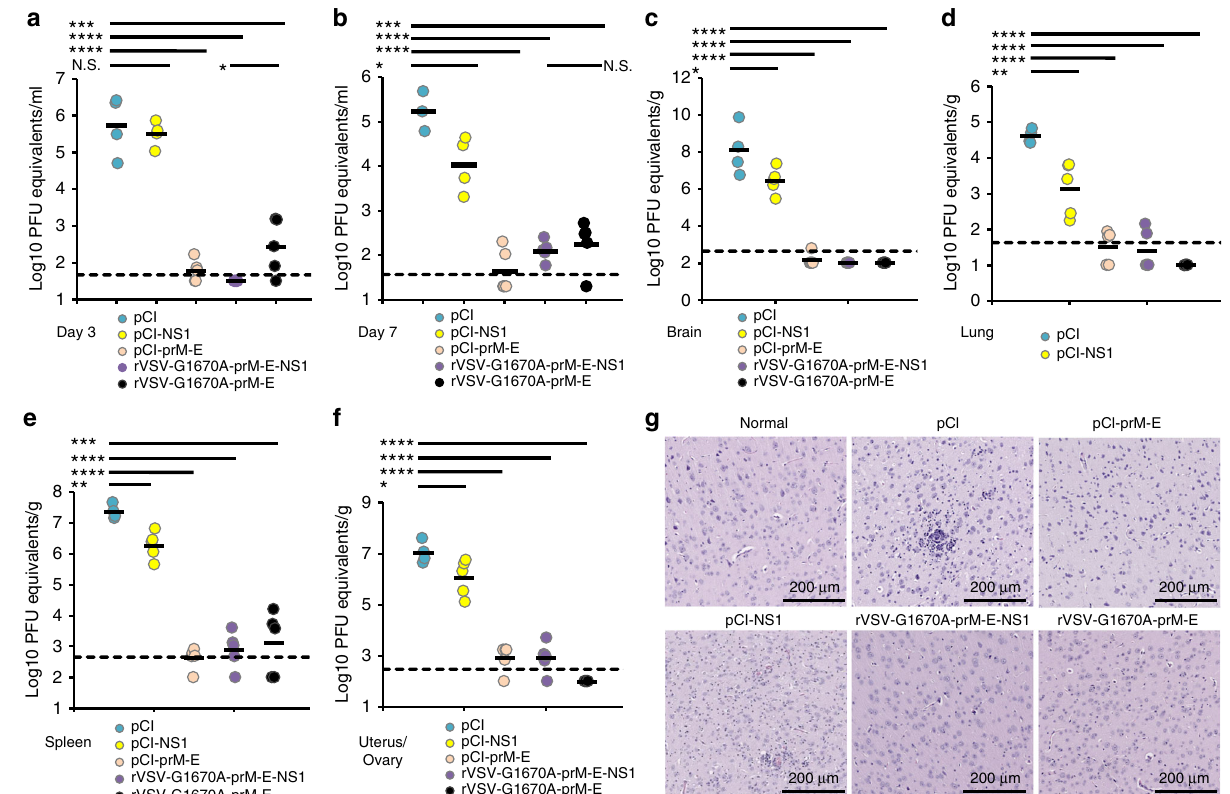
Fig. 7 MTase-defective rVSV (mtdVSV)-based vaccine protects A129 mice from viremia and prevents ZIKV replication in vivo. After ZIKV challenge, the level of viremia in A129 mice was measured by real-time RT-PCR at days 3 ( a ) and 7 ( b ) post-challenge. At day 7 post-challenge, all mice were terminated, brain ( c ), lung ( d ), uterus ( e ), and spleen ( f ) tissues were harvested and analyzed for ZIKV RNA by real-time RT-PCR. Data shown are GMT of 5 mice. Data were analyzed using t -test and compared to the placebo DMEM group or the pCI group (* P < 0.05; ** P < 0.01; *** P < 0.001; **** P < 0.0001; N.S., not signi fi cant, Student ’ s t -test). g mtdVSV-based vaccine prevents ZIKV-induced encephalitis in A129 mice. Half of brain tissue from each mouse was fi xed in 4% paraformaldehyde, embedded in paraf fi n, sectioned at 5 µ m, and stained with hematoxylin-eosin (HE) for the examination of histological changes by light microscopy. Micrographs with 10× magni fi cation (scale bar of 200 μ m) are shown. P value (by Student ’ s t -test) from top to bottom in each panel: a *** P = 0.000392, **** P = 6.62 × 10 − 6 , **** P = 1.80 × 10 − 5 , * P = 0.0236; b *** P = 0.000236, **** P = 1.07 × 10 − 5 , **** P = 4.67 × 10 − 5 , * P =